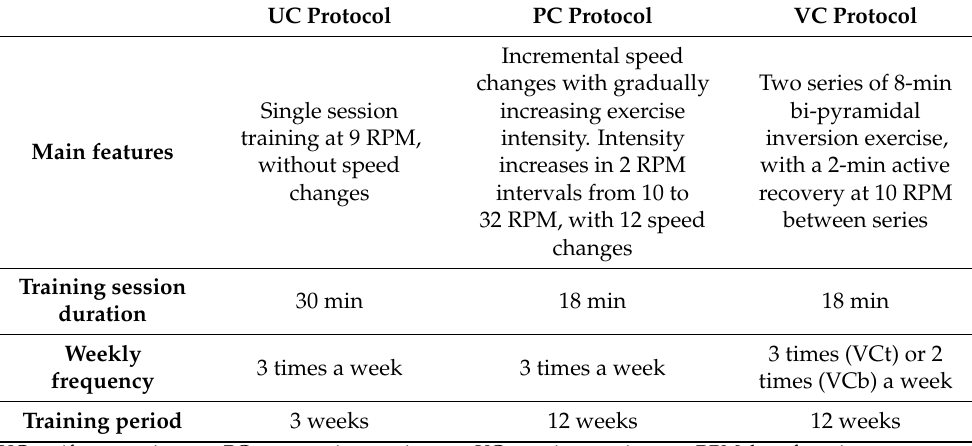
Table 1. A schematic description of the different aerobic exercise protocols used to train Npc1 mutant mice [121,122]. UC Protocol PC Protocol VC